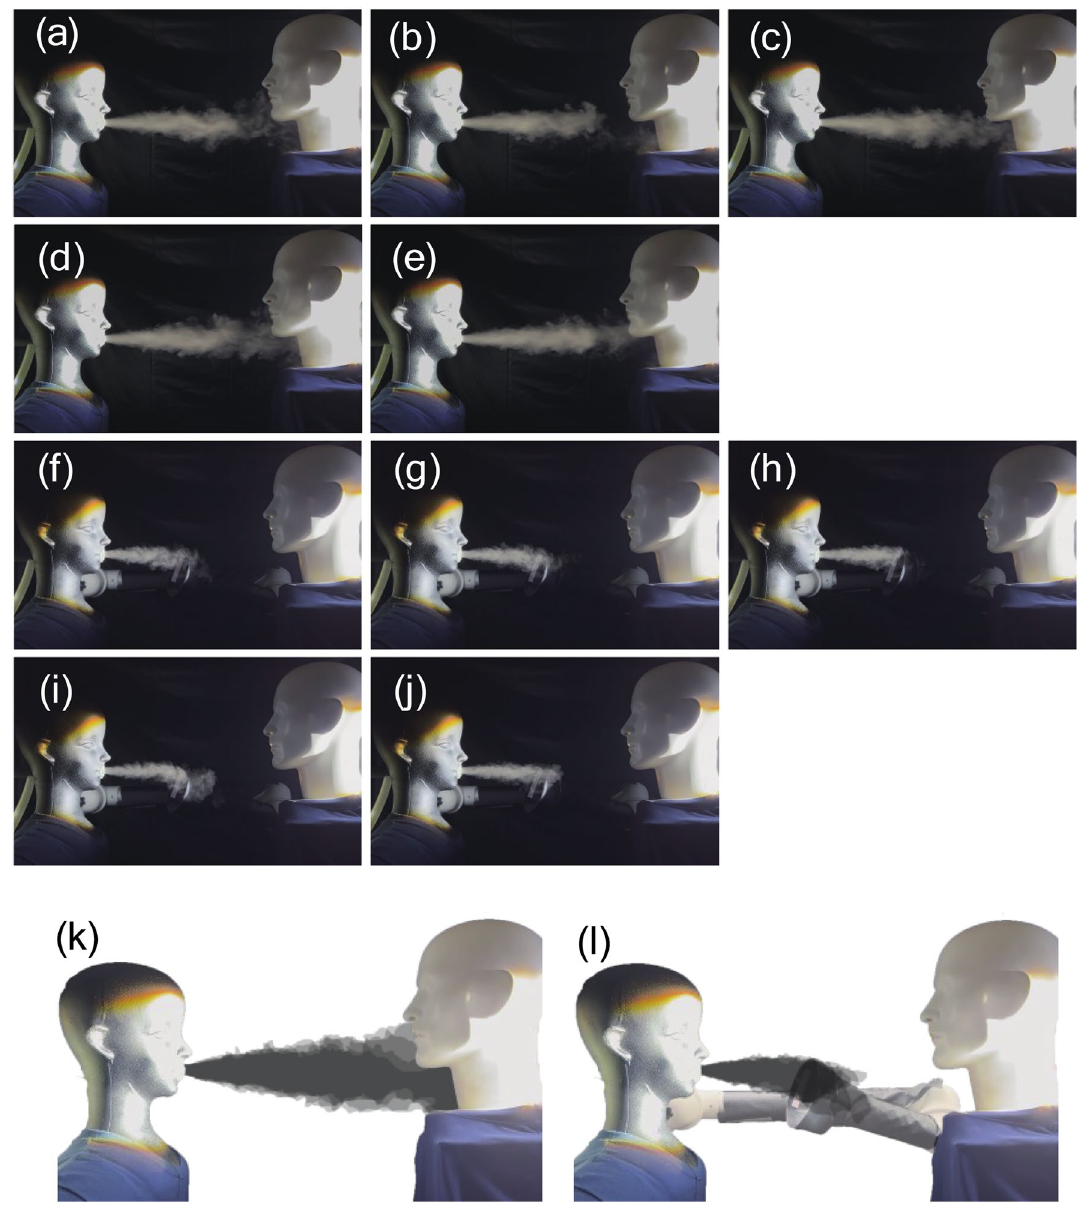
Figure 4. Photographs of the demonstration experiment without suction device ( a – e ), and with suction device ( f – j ) at 5 s intervals after a sufficient time had elapsed from the start of the mist jetting. Only the mist region of the images was extracted, and the mist region of the five pictures was layered without suction device ( k ) and with suction device ( l (100% and 75%) were analyzed. Computational hybrid meshes of the otolaryngology consultation room were generated by combining interior polyhedral elements with a five-layered prism mesh adjacent to the wall. The minimum prism height was 30 μm, and the total number of meshes was approximately 6 million. As a boundary condition, a flow velocity of 1.58 m/s (0.023 m 3 /s) was imposed at the inlet above “Door A”, 0.52 m/s (0.023 m 3 /s) was imposed at the outlet in the ceiling, and 1.6 m/s (0.063 m 3 /s) was imposed at the outlet and inlet of the air conditioner (Supplementary Fig. S1a). Following the conditions present during a medical examination, Door A was closed and a constant atmospheric pressure was imposed at the open Door B. A no-slip condition was applied to the other walls. The flow perpendicular to the opening of the human mouth (Supplementary Fig. S1d) was analyzed in two cases: (i) a constant expiratory rate of 2.5 m/s (0.00075 m 3 /s) [X] (Case X) and (ii) 10 consecutive coughs using flow waveforms (Supplementary Fig. S2) obtained from previous studies [Y] (Case Y) 21 . Case X models an examination using an otoscope, during which the patient’s mask must be removed, and assumes an expira- tion rate typical of normal conversation 22 . Case Y models coughing, a major symptom of COVID-19, during